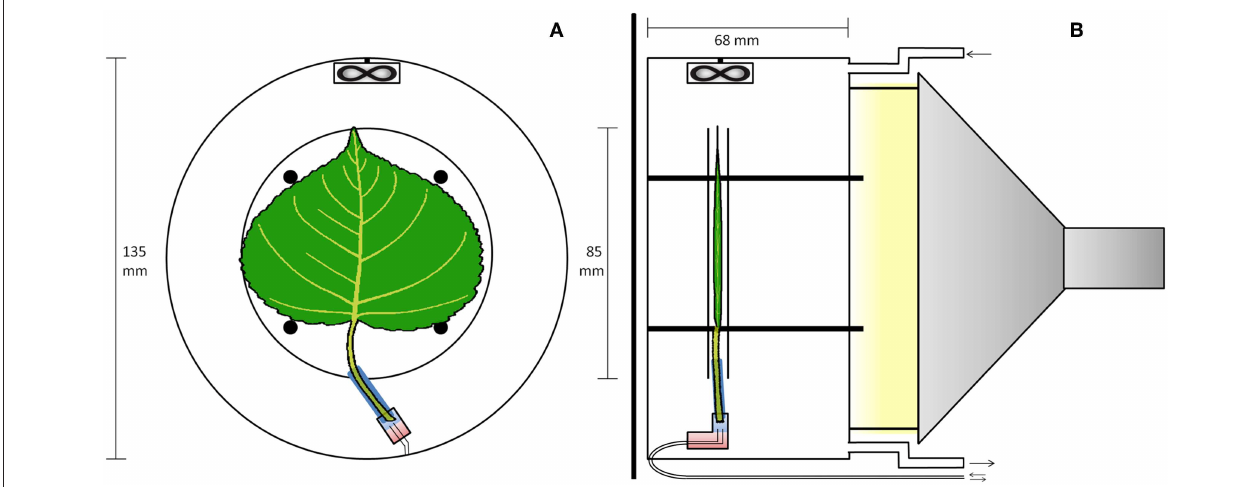
FIGURE 1 | PET imaging setup with the leaf inside the cuvette. (A) Transverse view of the cuvette. An elastic polysiloxane sleeve (blue) seals the petiole to the plastic elbow junction (rectangle), and two-component epoxy (red) seals two (0.6mm inner diameter) tubes to the junction for delivering solutions, as in Figure 2 . (B) Sagittal view of the cuvette. The leaf is sandwiched between two planar nylon meshes (not shown) woven between four posts, while two 4mm plexiglas discs (apparent in both A,B ) are placed to trap positrons that escape the leaf. The fan ensures good mixing of air flowing through the cuvette. The light source was outside the scanner, attached to the cuvette using three metal